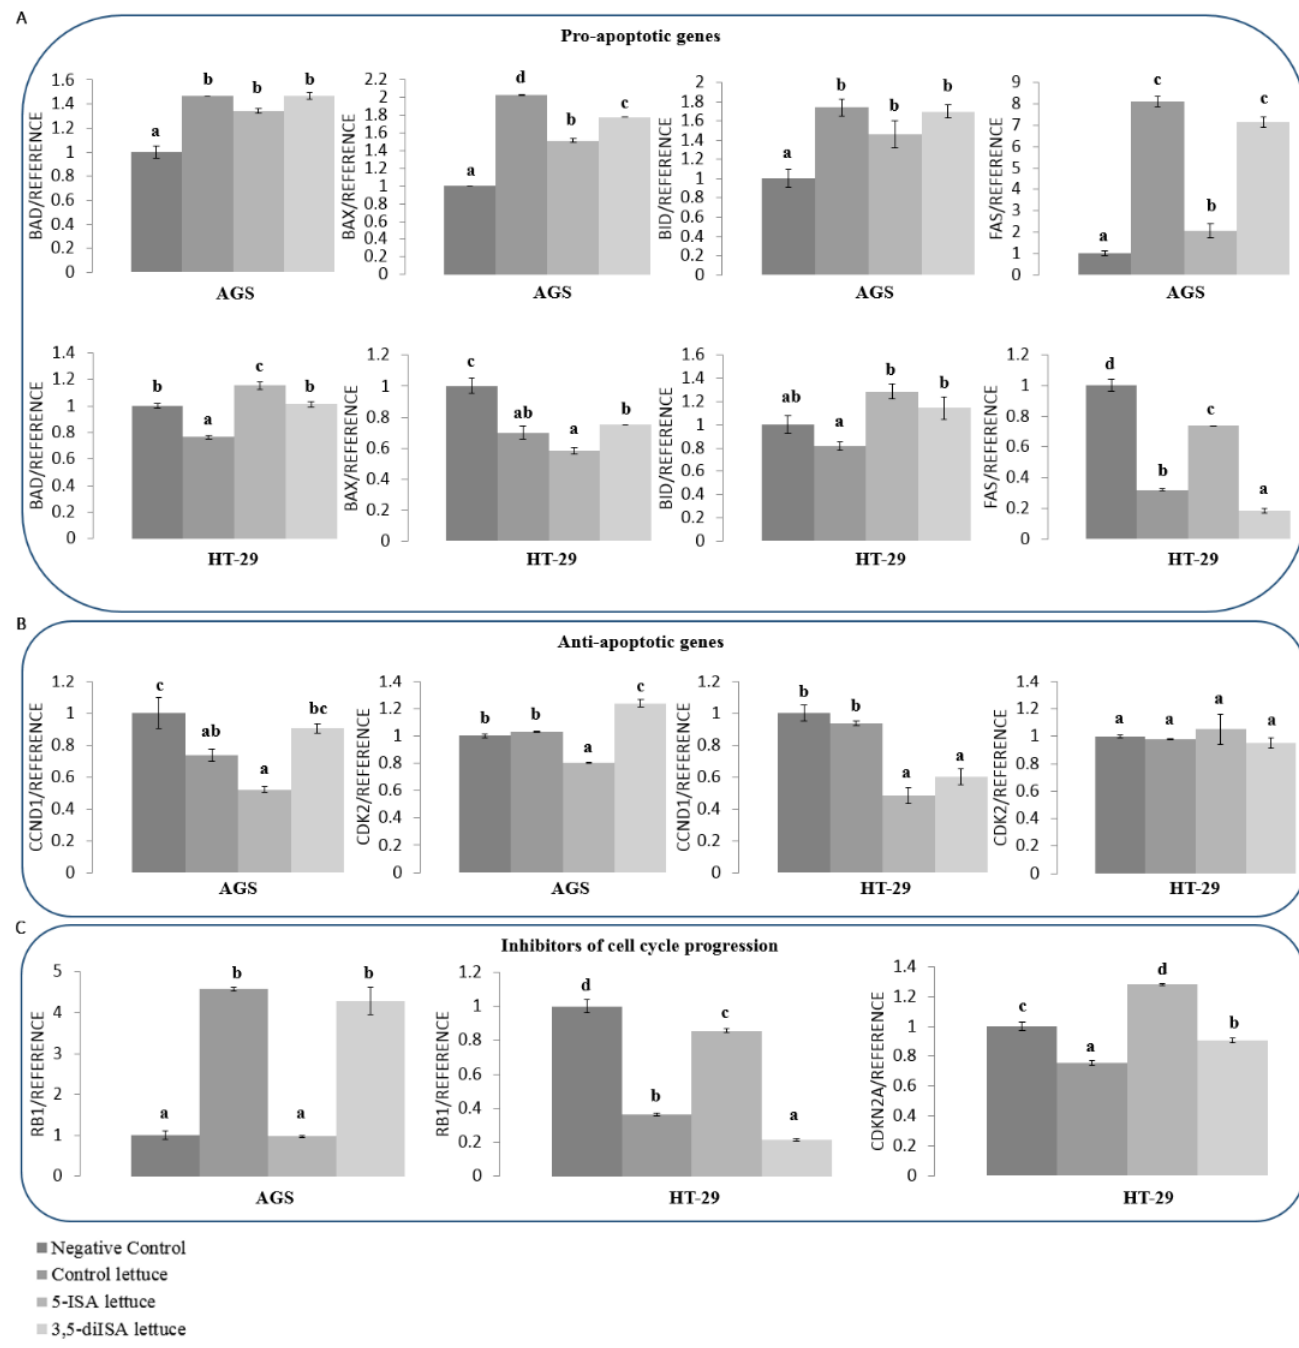
Figure 4. The effect of extracts from iodine-biofortified lettuce on mRNA expression of genes in human cancer cells of AGS and HT-29 cell lines. ( A ) Pro-apoptotic genes. ( B ) Anti-apoptotic genes ( C) Inhibitors of cell cycle progression. Cells were treated for 48 h with 1000 µg/mL extract from control lettuce, or 5-ISA-fortified lettuce, or 3,5-diISA-fortified lettuce. The results are shown as means ± SD. Statistical significance of treatment: Statistical significance was assessed using one- way ANOVA followed by Tukey’s post hoc. Columns with the same letter are not significantly different ( p > 0.05).